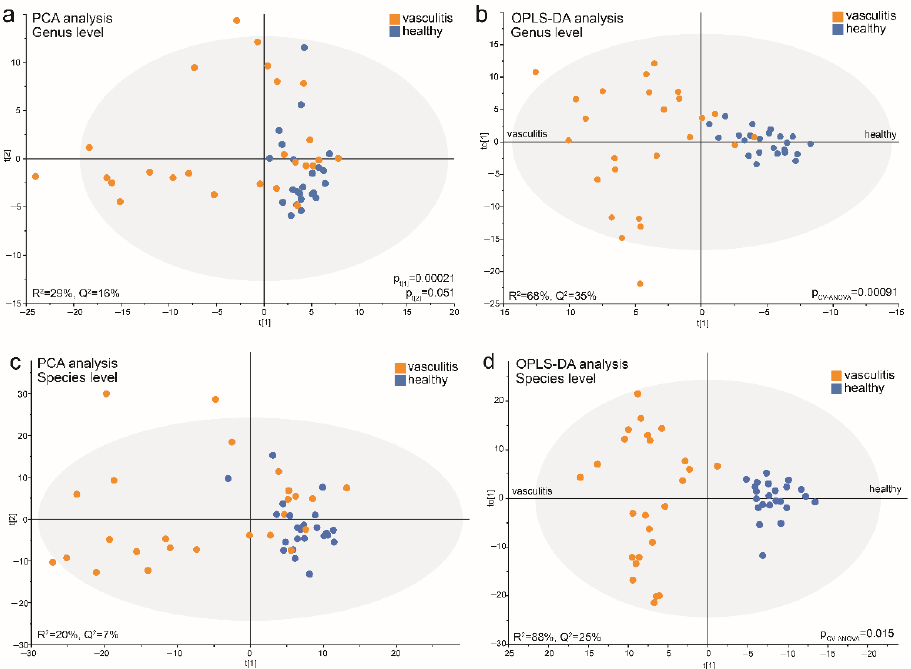
Figure 6. Multivariate models of saliva microbiota in acute AAV patient and control samples run at the genus and species levels. PCA score plots show the position of each participant (dot) based